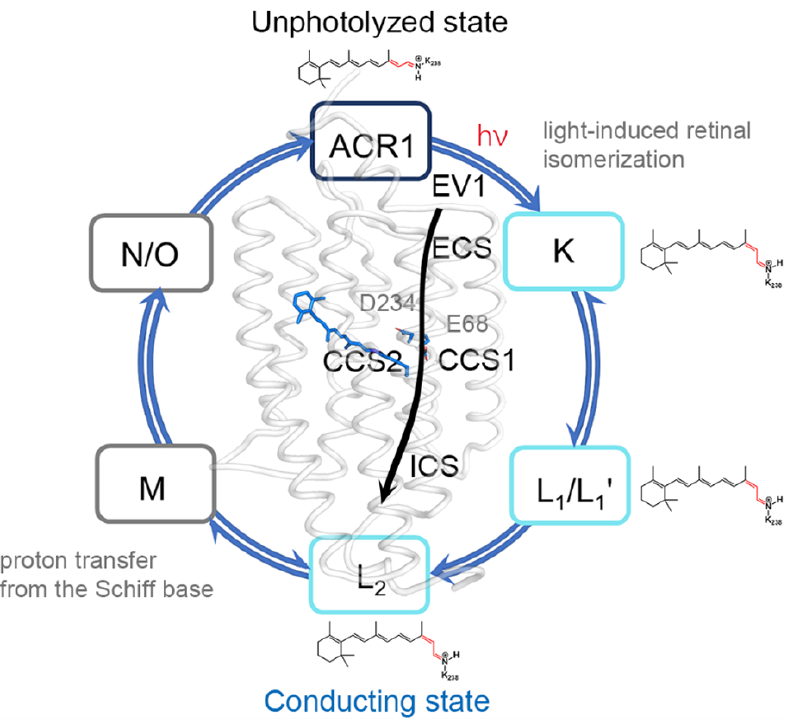
Figure 1. The GtACR1 photocycle. The potential ion channel is indicated by the black